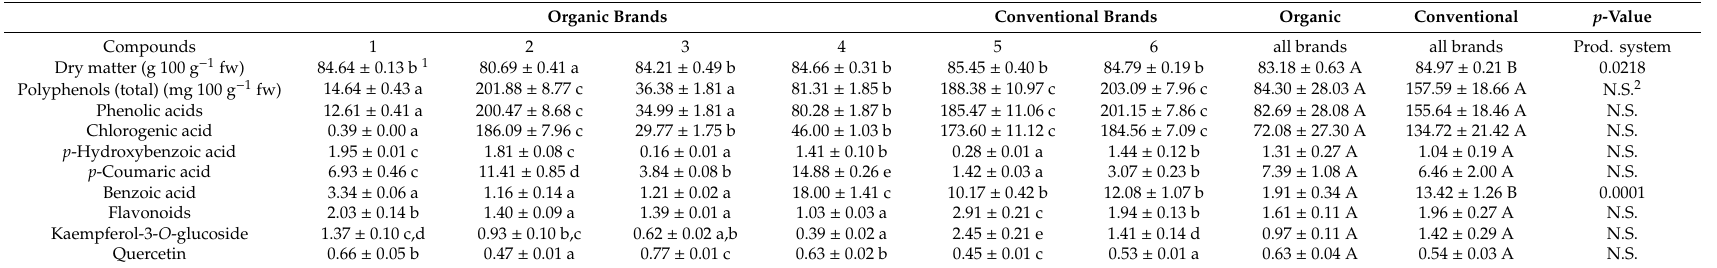
Table 3. The content of dry matter and phenolic compounds in dried cranberry fruits of selected organic and conventional brands. Organic Brands Conventional Brands Organic Conventional p -Value